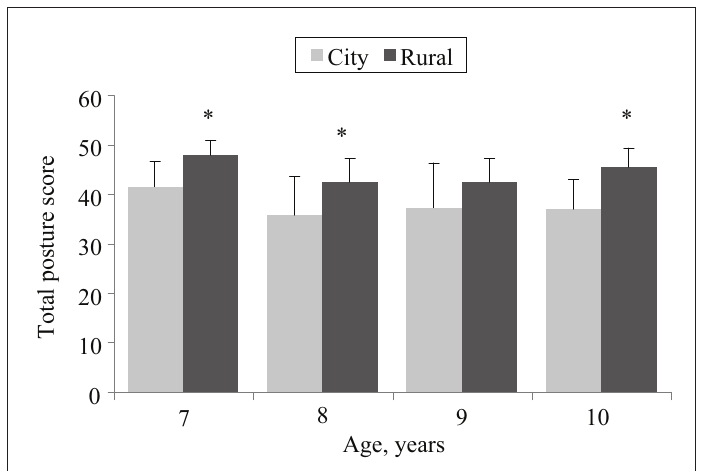
Figure 3. Alignment of different body segments in rural and city boys